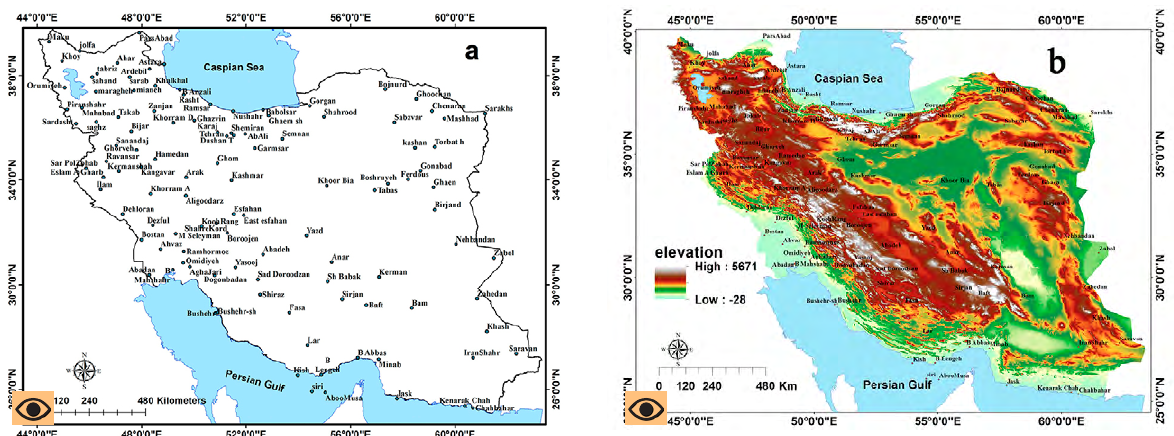
Figure 1. The location (a) and elevation (b) of the stations under the